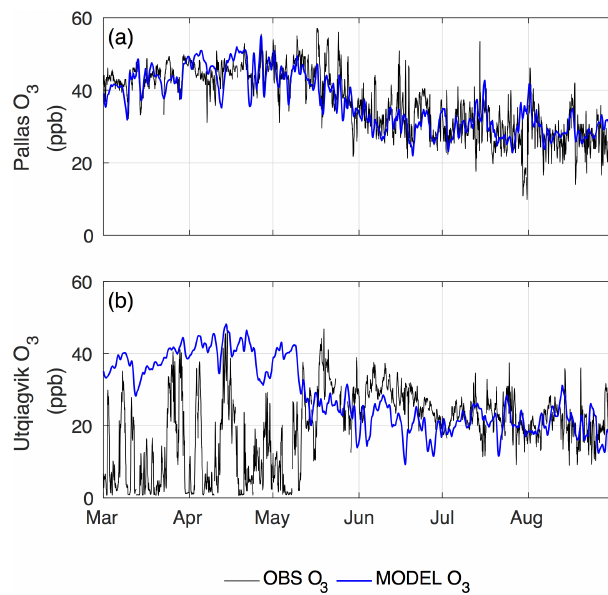
Figure 15. Observed and model-predicted ozone concentrations at two Arctic surface stations for March–August 2012; WRF-Chem in blue and observations in black. The model does not capture ozone depletion events observed at Utqia ˙ gvik during Arctic spring. At Pallas, an inland site where no bromine activation is expected, the model in the present state captures the full spring–summer seasonal cycle of